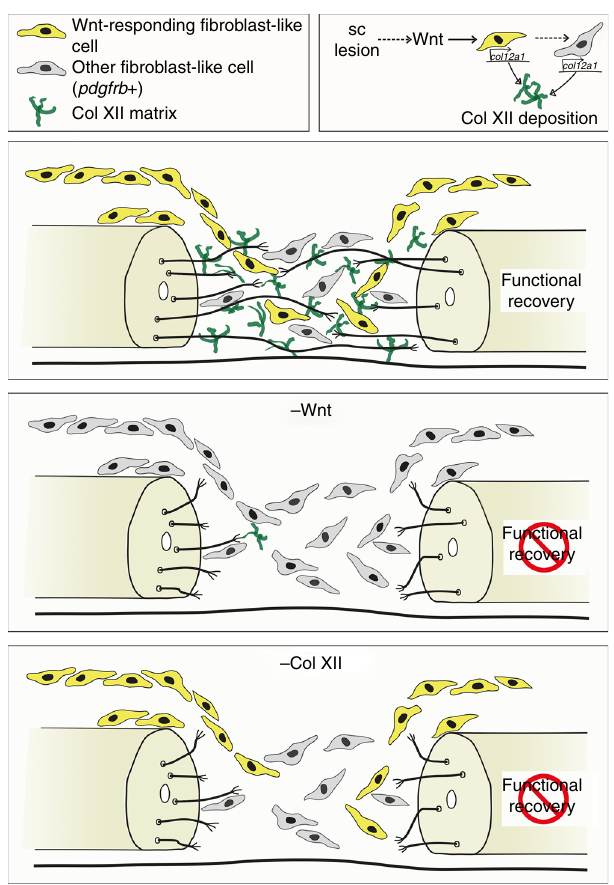
Fig. 8 Model for Wnt/ β -catenin function during axonal regeneration in the zebra fi sh spinal cord. Spinal cord (sc) lesion triggers Wnt/ β -catenin pathway activation in fi broblast-like cells. Wnt/ β -catenin signaling controls col12a1a/b transcription and deposition of Col XII in the lesion site ECM, through which axons regenerate to facilitate functional